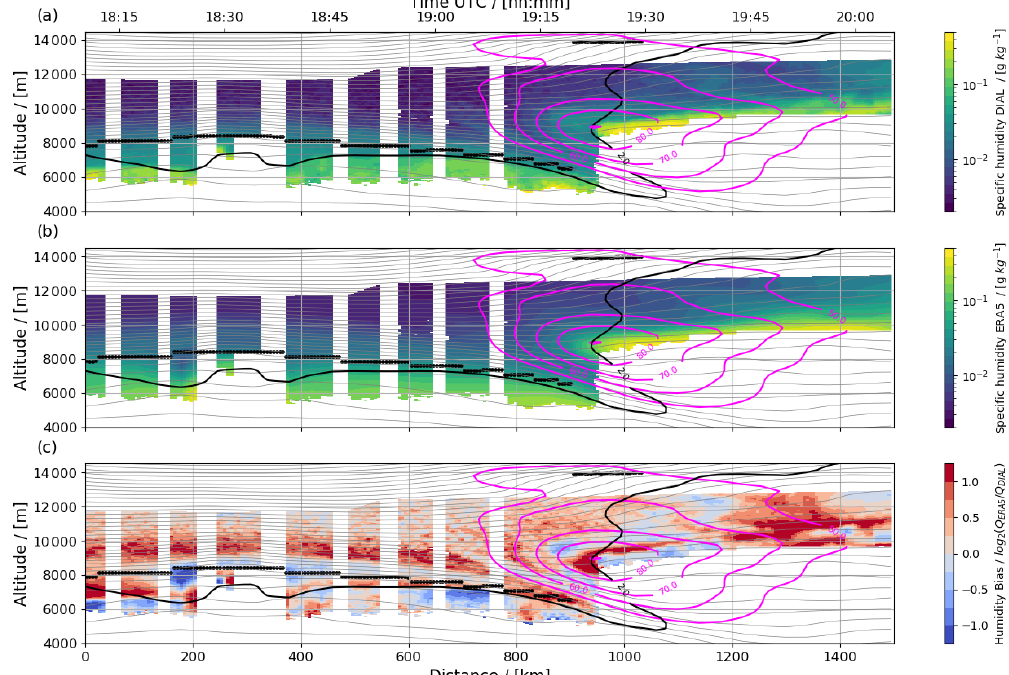
Figure 4. Vertical cross sections of (a) the DIAL specific humidity (colour shading, gkg − 1 ), (b) ERA5 specific humidity (colour shading, gkg − 1 ), and (c) the corresponding humidity bias (colour shading) on 1 October 2017. Panels (a) – (c) are superimposed by ERA5 fields of the potential temperature (grey contours, (cid:49)θ = 3K), the isopleths of the wind speed (magenta contours, in ms − 1 ), and the thermal (thick black dots) and the dynamical tropopause (2PVU, black